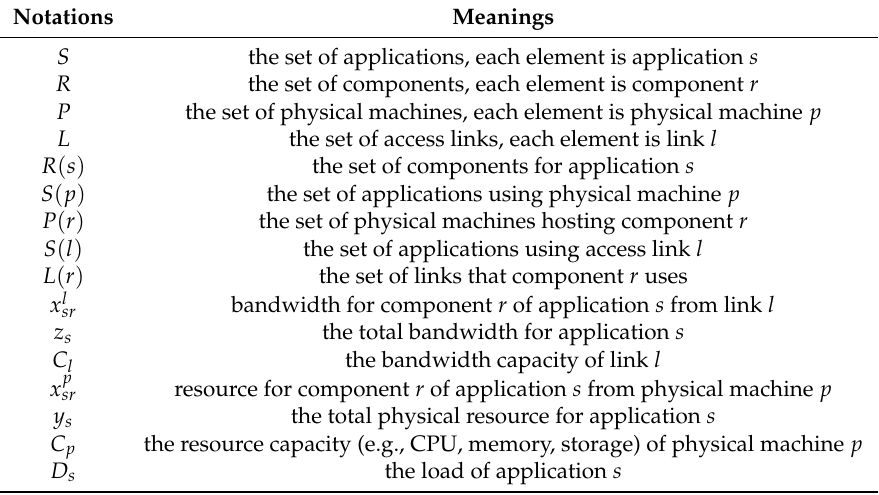
Table 1. Notation